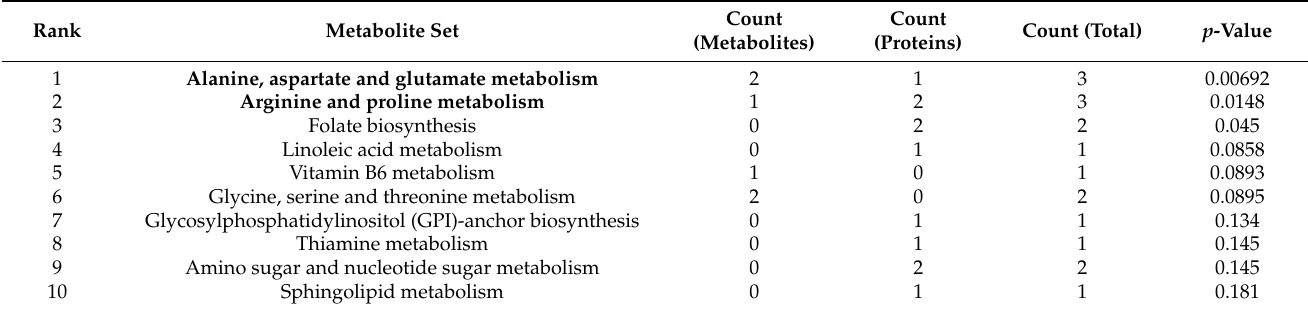
Table 4. Top 10 KEGG Global Metabolic Pathways for proteins and metabolites with decreased or increased abundances in CaOV3 cells. Terms in bold represent those which are represented in both OVCAR-5 and CaOV3